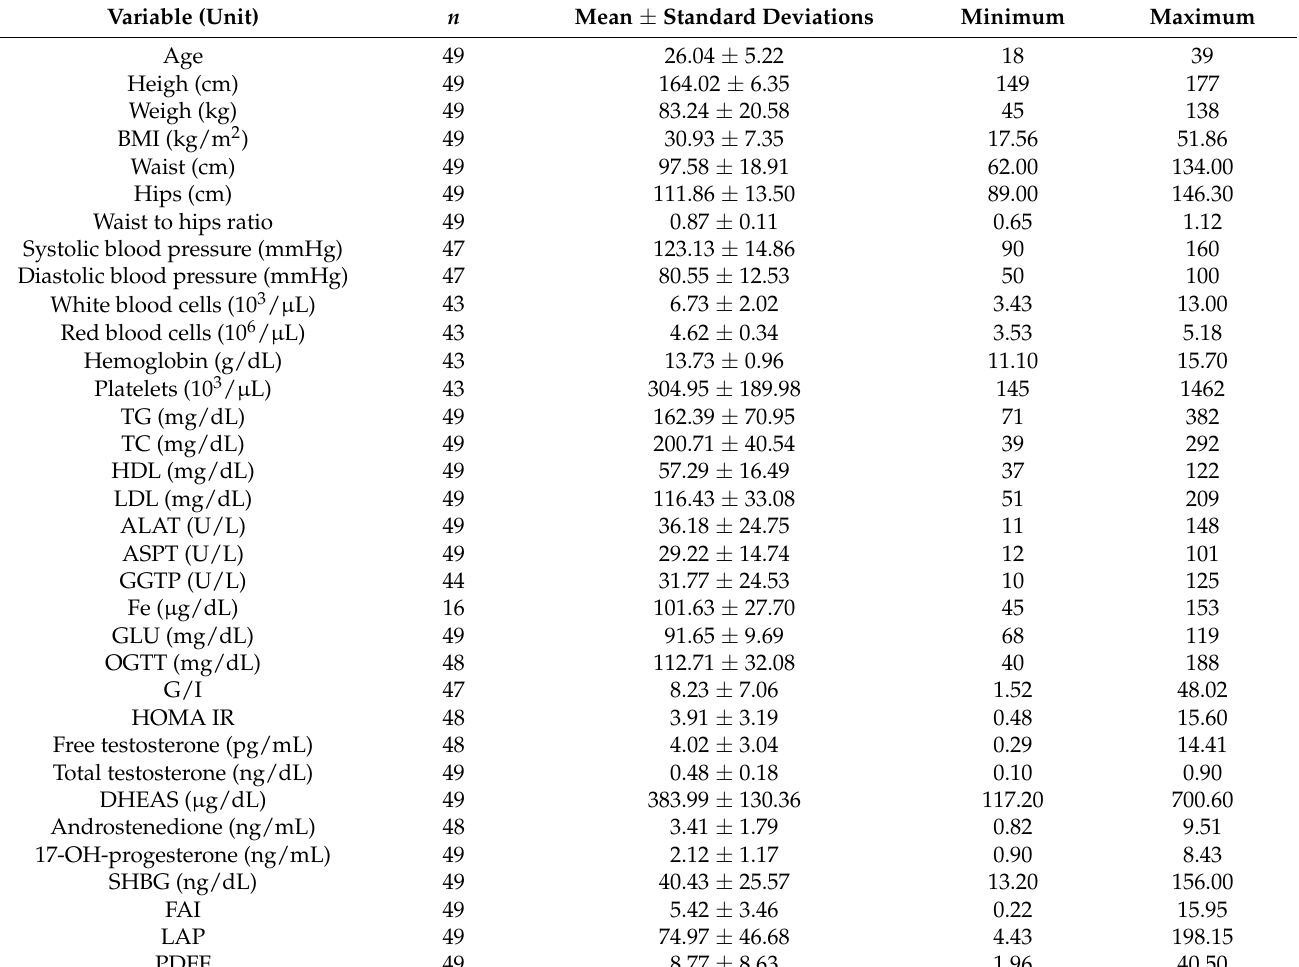
Table 1. Descriptive statistics of the studied